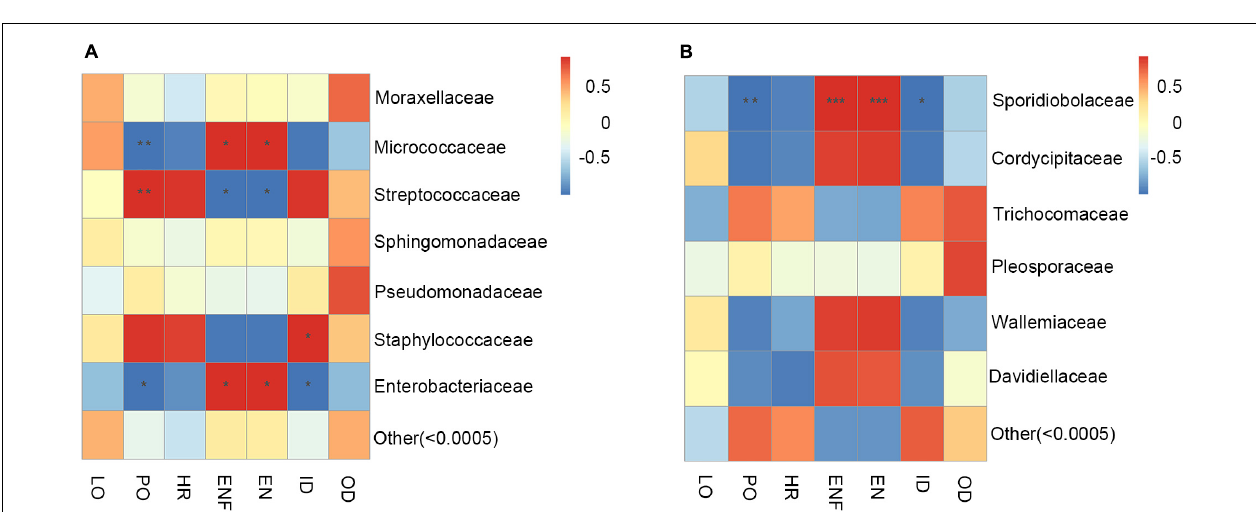
FIGURE 7 | The correlation heatmap of gut microbiota and biological parameters. (A) Bacterial at the family level. (B) Fungus at the family level. Red represents positive correlation; blue represents negative correlation, * shows 0.01 < p < 0.05, ** shows 0.001 < p < 0.01, *** shows p < 0.001. LO, longevity; PO, pre-oviposition; HR, hatch ratio; ENF, eggs numbers/per female; EN, eggs/day; ID, incubation period; OD, oviposition